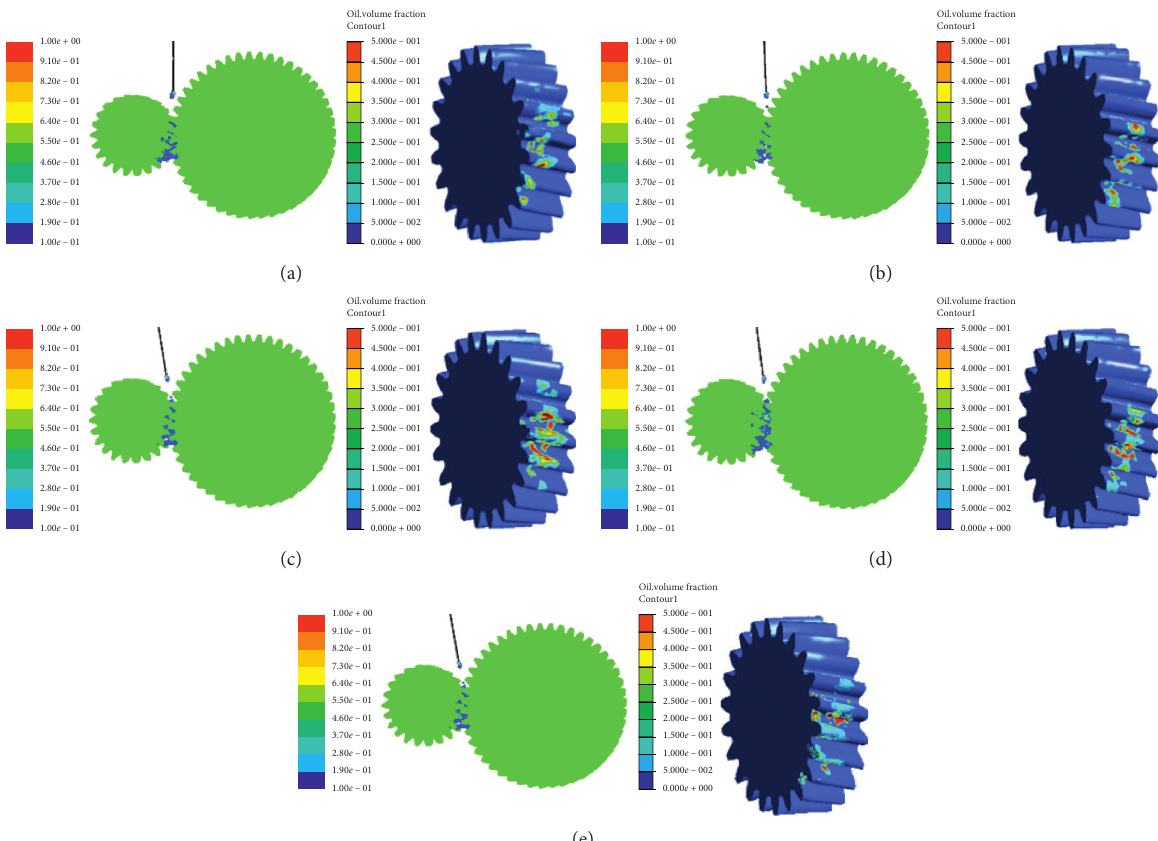
Figure 6: Flow field distribution of the meshing side under different injection angles: (a) 0 ° ; (b) 2.5 ° ; (c) 5 ° ; (d) 7.5 ° ; (e) 10 °